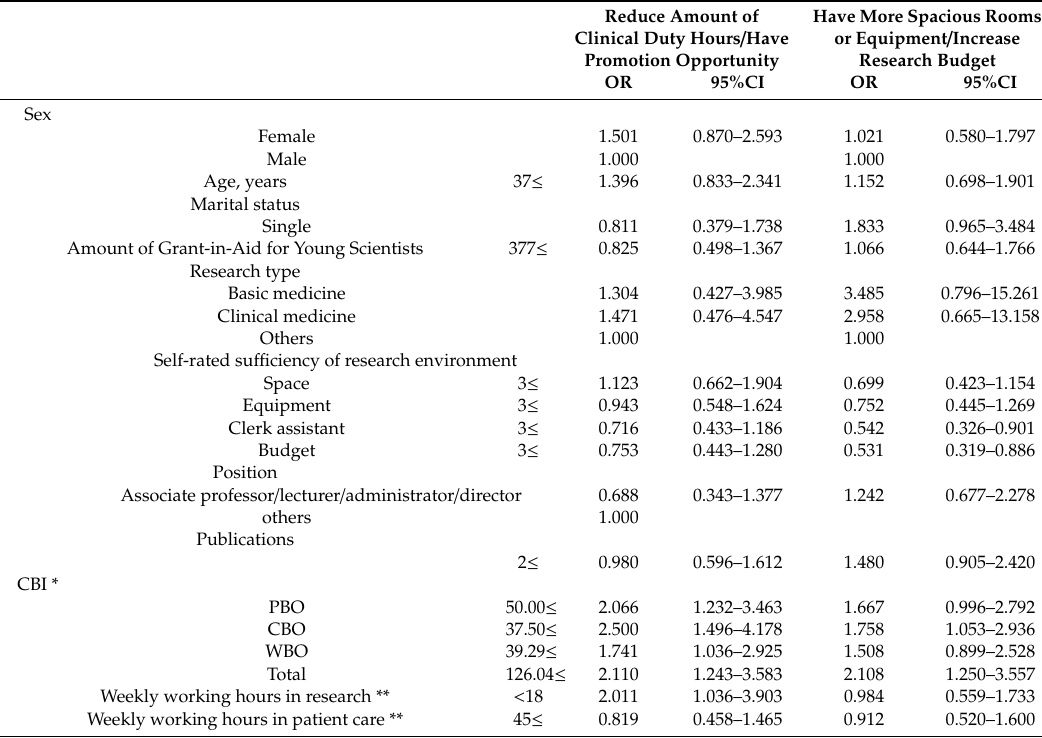
Table 3. Odds ratios of each covariate for the two types of negotiation experiences.